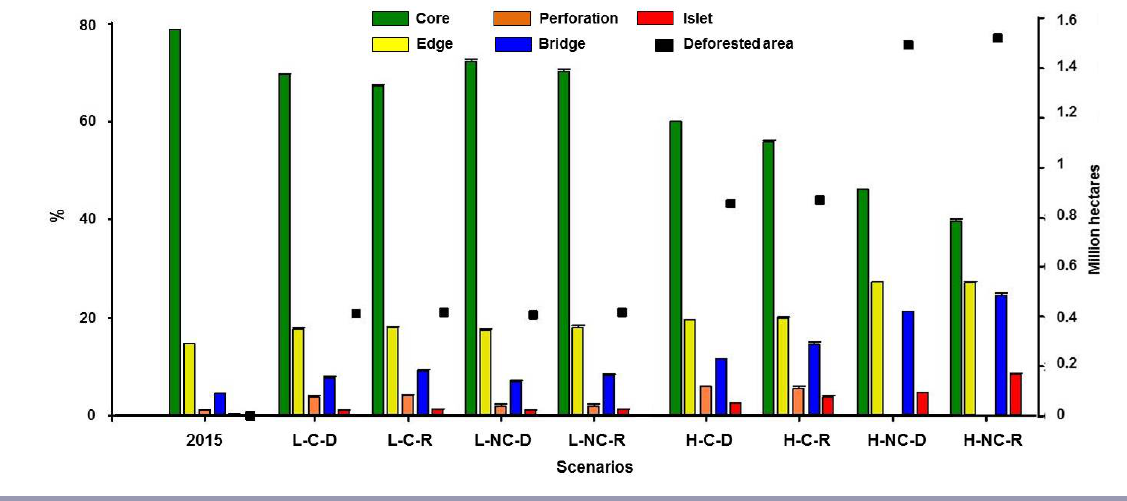
Fig. 4. Mean (min/max) share of forest area in different fragmentation classes (Bars, left axis) and deforested area (dots, right axis) among the scenarios. Scenarios differ in deforestation rates (L: low, H: high), spatial planning at the regional level (C: with corridors, NC: without corridors), and spatial planning at the plot level (D: design, R: random). Core = interior forest; Edge =outer edge of core forest (300 m in our case); Perforation = edge inside core forest patches; Bridge: forest linking forest patches; Islet: small forest patches without core forest.